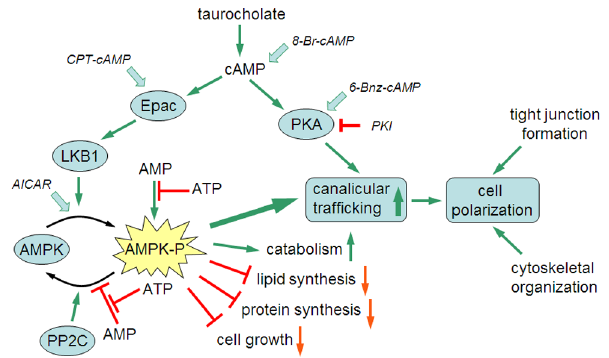
Figure 7. ABCB11 canalicular trafficking model based on experimental observations in sandwich-cultured mouse hepa- tocytes. Taurocholate, cAMP and AICAR enhanced ABCB11 trafficking to the canalicular membrane of hepatocytes. Canalicular delivery of ABCB11 was greatly reduced in the LKB1-decficient cell. The acceler- ating effects of taurocholate and AICAR were prevented by the disruption of LKB1. In contrast, addition of cAMP augmented ABCB11 trafficking even in the LKB1-deficient cells. Activation of Epac by CTP- cAMP also led to enhanced canalicular trafficking, however, its effect was LKB1-dependent. Specific activation of PKA by 6-Bnz-cAMP results in increased canalicular trafficking of ABCB11 independently of LKB1. The accelerating effect of cAMP was blocked by specific inhibition of PKA in LKB1-deficient cells, suggesting a PKA-dependent regulatory pathway in control of ABCB11 trafficking. PP2C – Protein